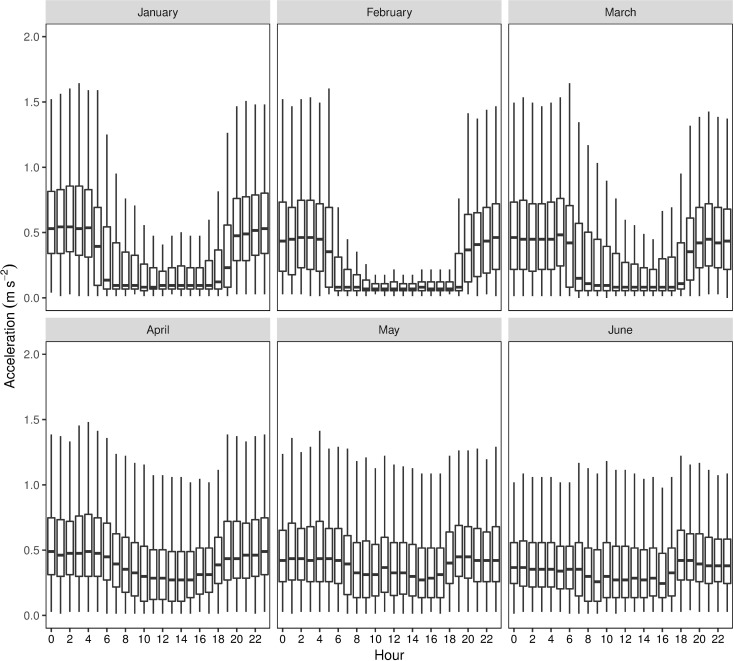
Combined hourly acceleration values of Murray cod (Maccullochella peelii; n = 18) for each calendar month of the study.Data are represented as median, 25th and 75th percentiles (box) and 5th and 95th percentiles (whisker).